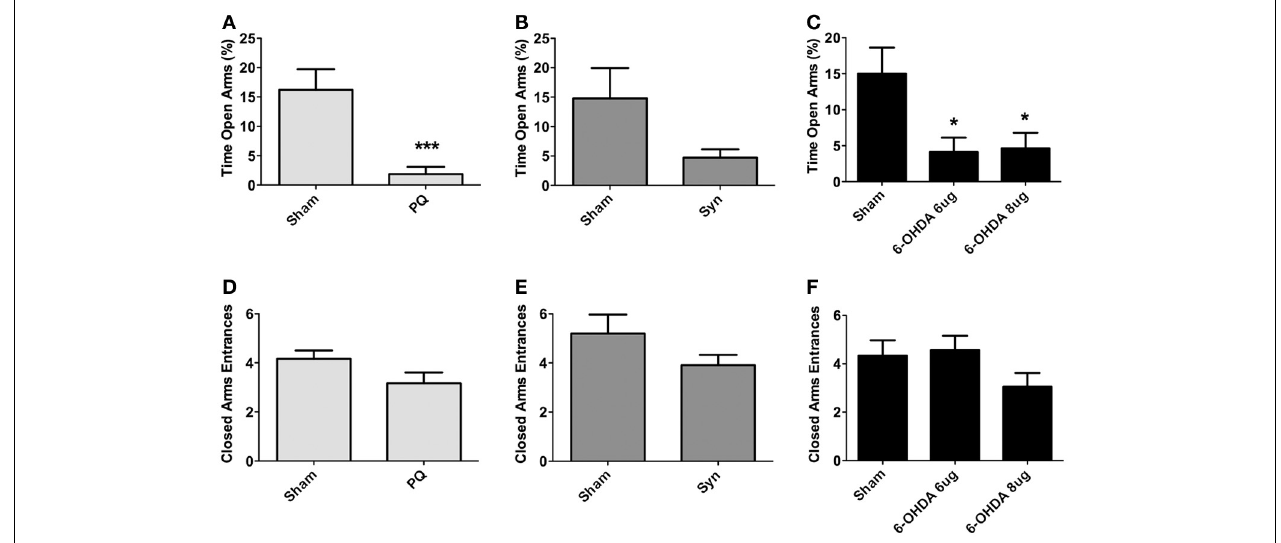
FIGURE 5 | Anxiety-like behavior in the elevated-plus maze. Data on percentage of time in open arms (A–C) , and number of entries in closed arms (D–F) . Data expressed as mean ± s.e.m. ∗ p < 0 . 05 and ∗∗∗ p < 0 .